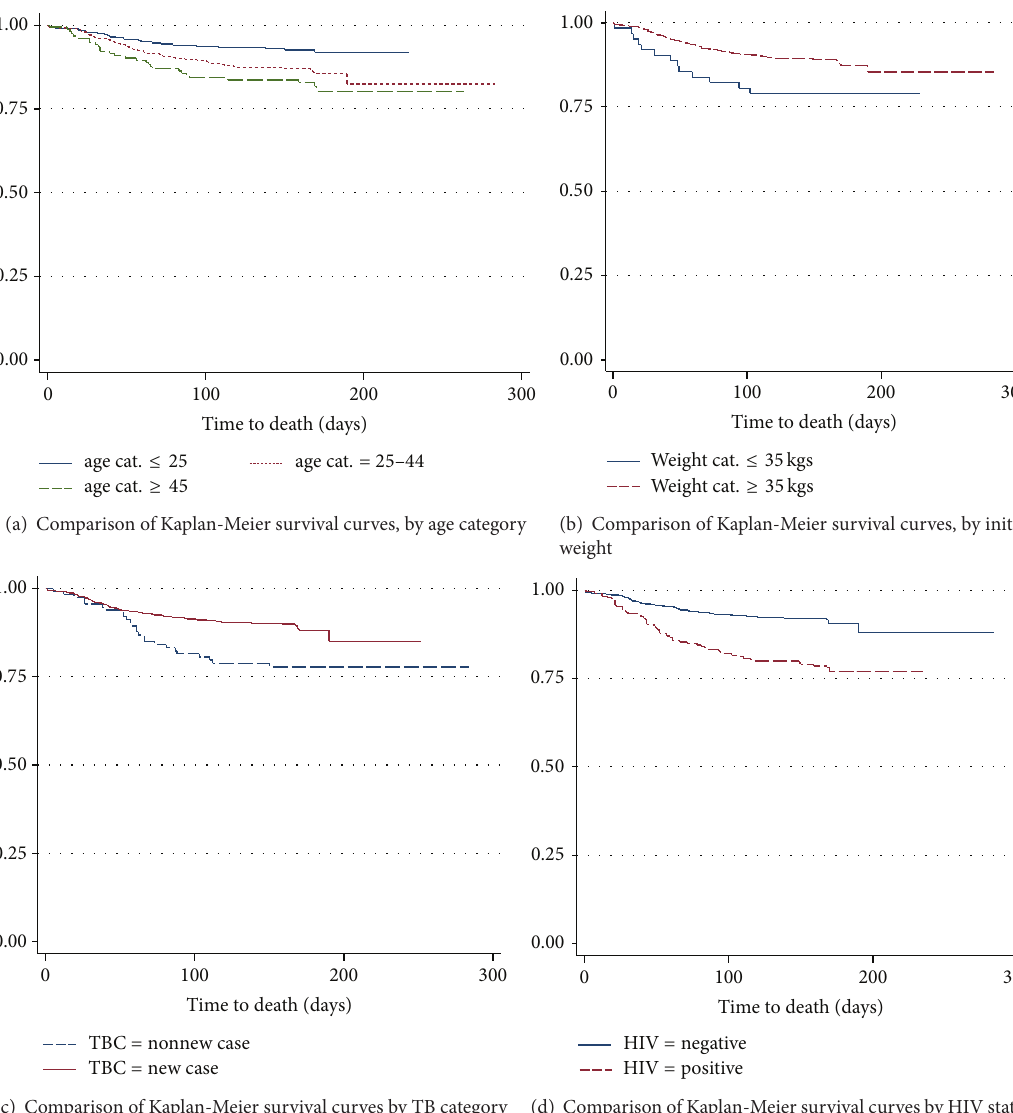
Figure 1: The plot of the estimate of Kaplan-Meier survivor curves of TB patients under DOTS in AA health centers (a) age category, (b) initial weight of patients, (c) TB patient category, and (d) HIV status.